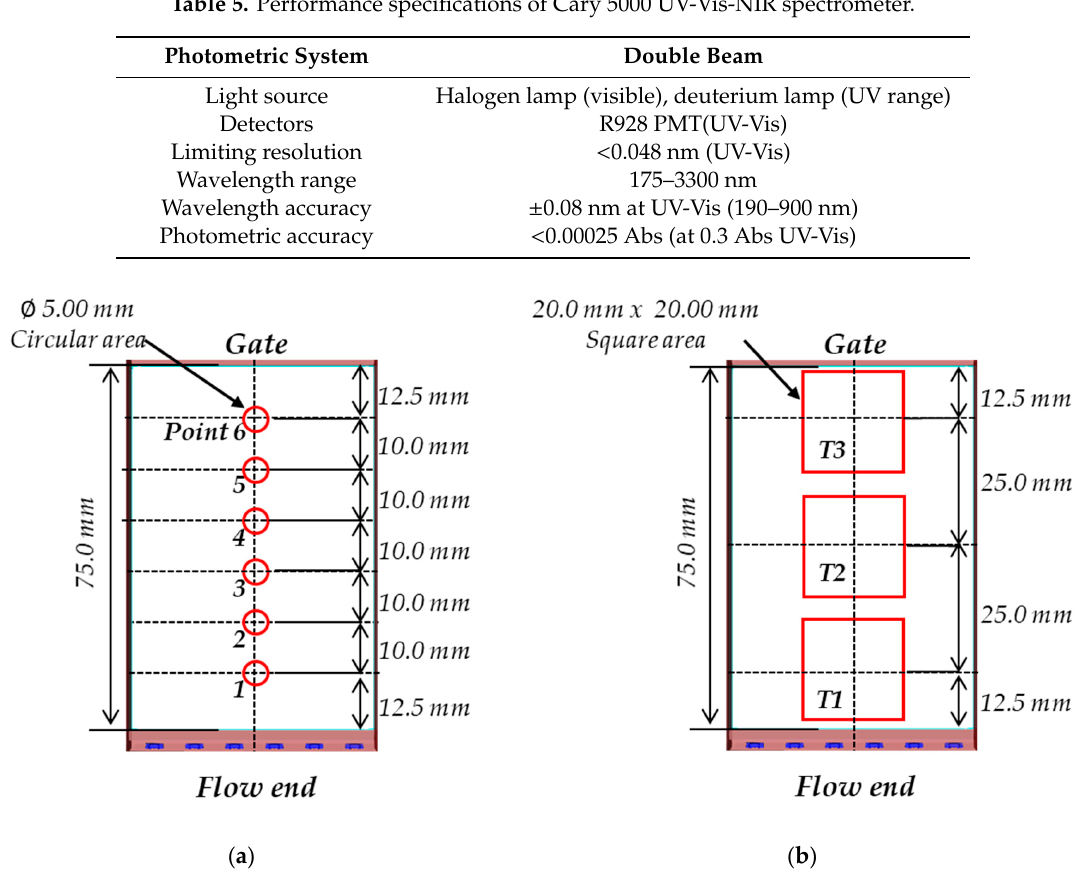
Figure 6. Measurement points for ( a ) direct transmittance and ( b ) total transmittance.